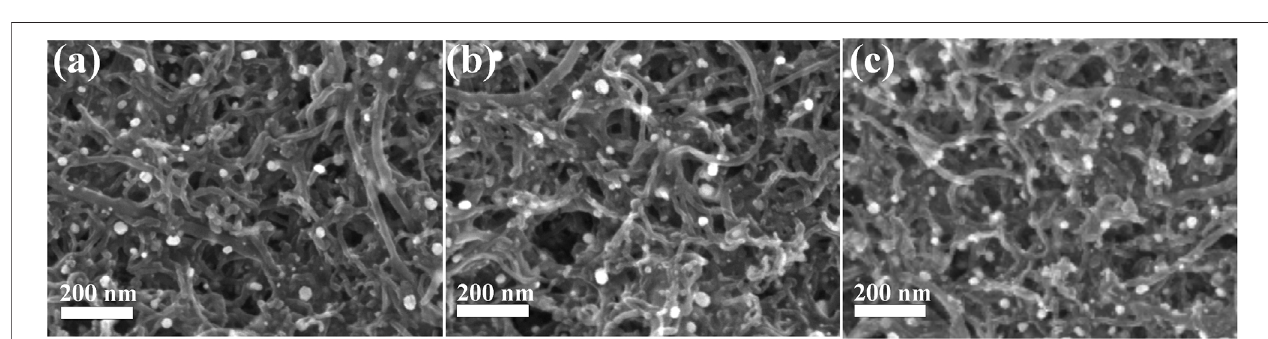
Frontiers in Chemistry |